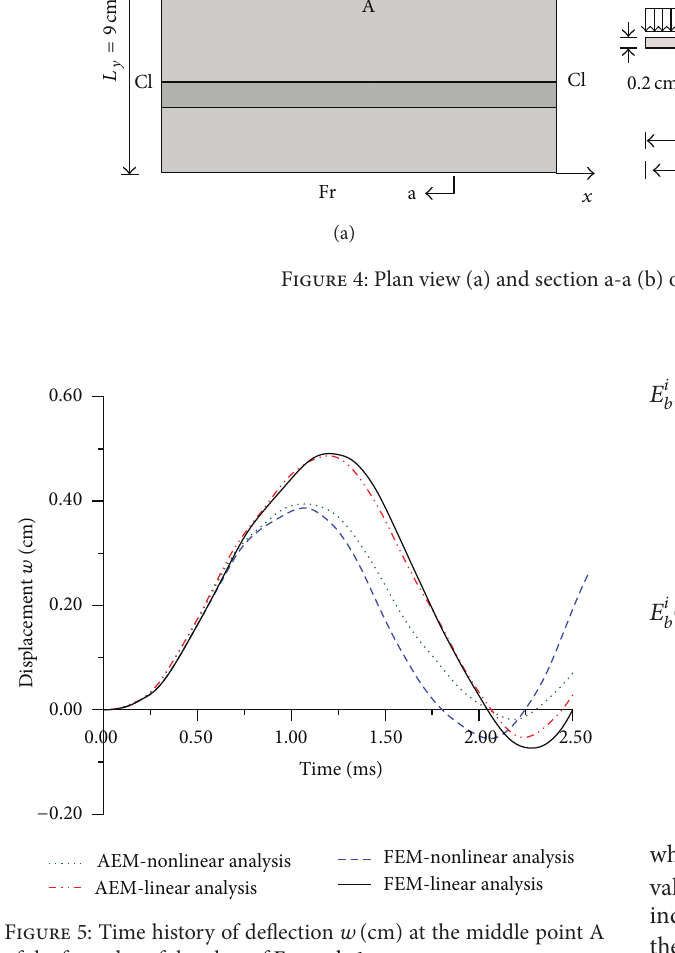
Figure 5: Time history of deflection 𝑤 (cm) at the middle point A of the free edge of the plate of Example